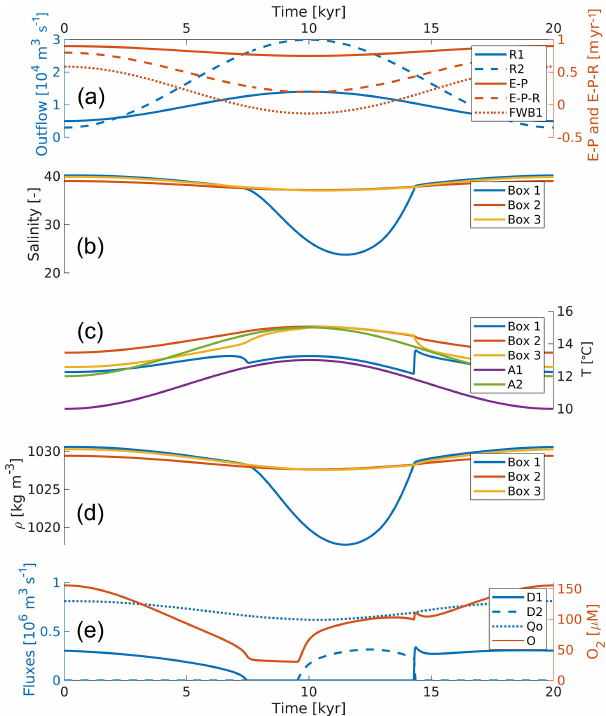
Figure 5. The forcing and results of the run in which the freshwa- ter budget of the margins becomes positive for a brief period. The layout of the panels is the same as in Fig.